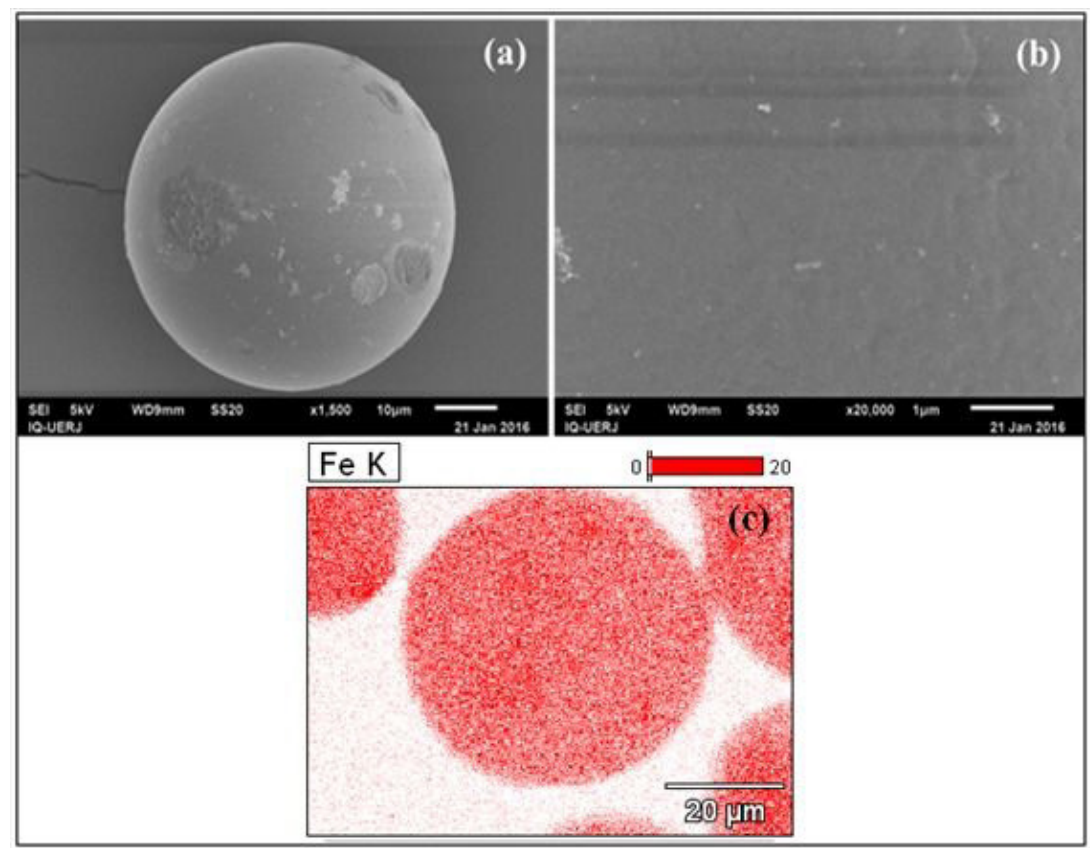
Figure 5. Scanning electron microscopy of microspheres based on gelatin, fructose and magnetite obtained by ferrous chloride (MEFC). (a) microsphere at 1500X (b) microsphere surface at 20000X and (c) energy dispersive X-ray spectroscopy of iron distribution.